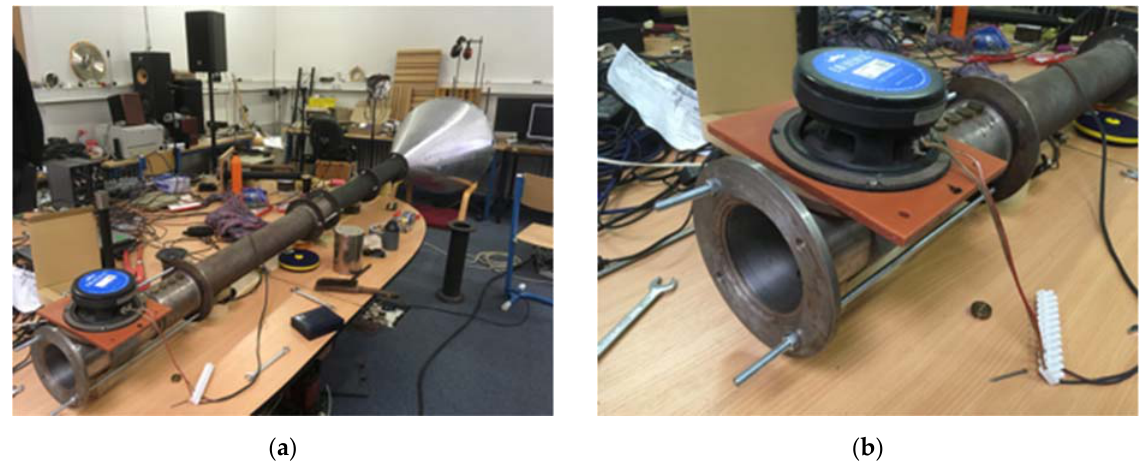
Figure 4. The measurement setup modification description. ( a ) Photo of full setup; and ( b ) the axis perpendicular side connection of LS.